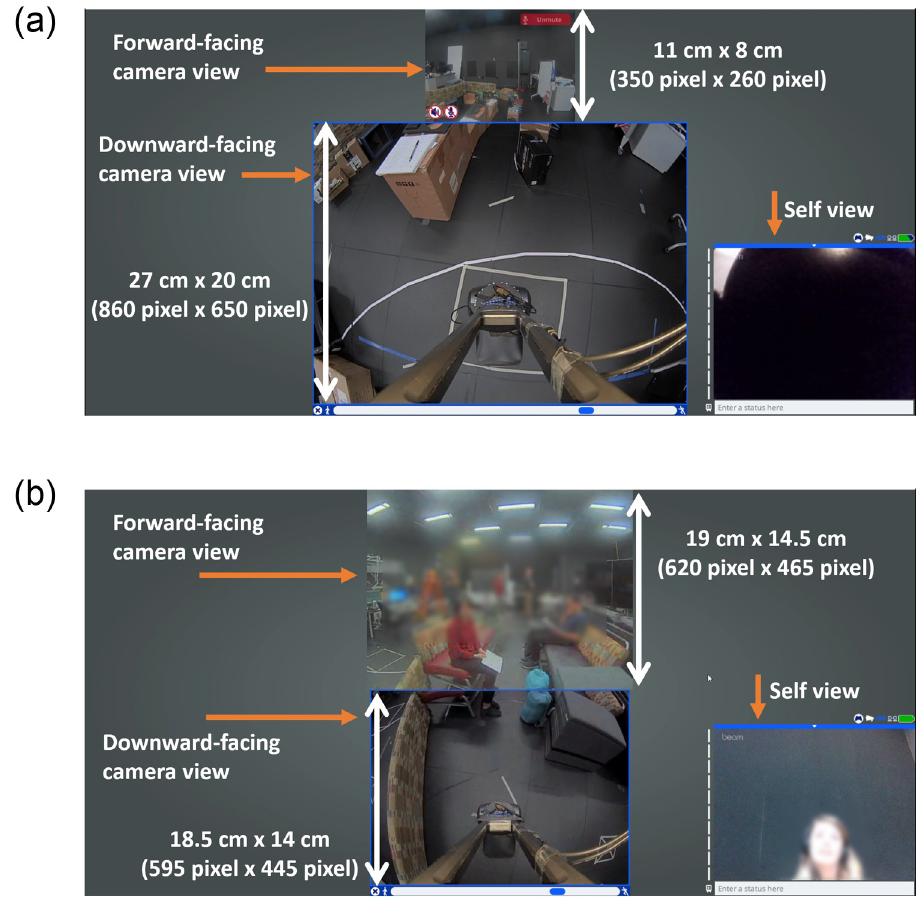
Fig 2. Beam GUI Layouts during the experiment. Layout for (a) User Study 1 and (b) User Study 2. Parts of images blurred for